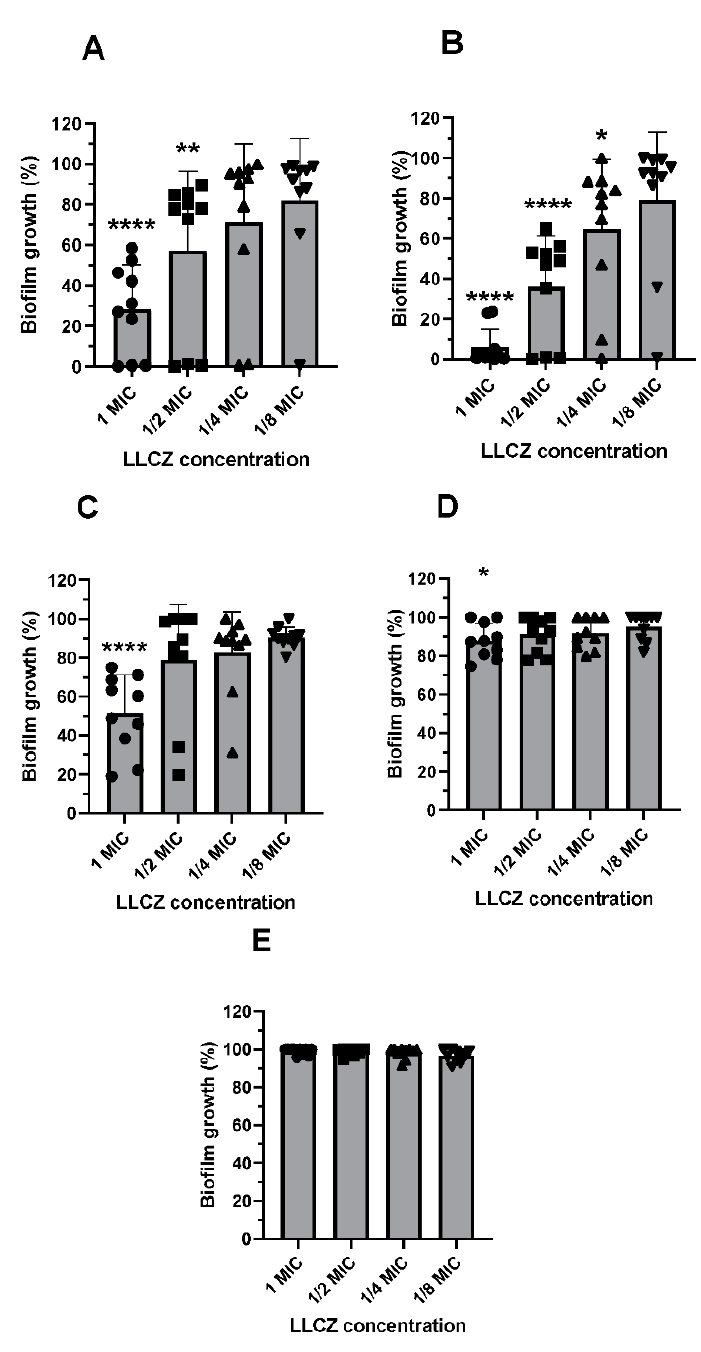
Figure 3. Growth of A. fumigatus biofilm (10 isolates), when treated with luliconazole (XTT assay). Isolates were treated with concentrations of 1- ( • ), 1/2- ( (cid:4) ), 1/4- ( (cid:78) ) and 1/8 ( (cid:72) ) times the isolate specific minimal inhibitory concentration at: ( A ). 0 h ( B ). 4 h, ( C ). 12 h ( D ). 24 h and ( E ). 48 h after incubation start at 35 ◦ C. The isolates were incubated with LLCZ for 24 h at 35 ◦ C and subsequently washed twice with 1 × PBS and incubated with XTT (0.5 mg/mL) + Menadione (25 µ M) for 3 h. The optical density was measured at 492 nm. Statistical significance was determined by Dunnett’s multiple comparison tests, p < 0.05 was stated as significant and the confidence score was indicated by asterisks: *: p < 0.05, **: p < 0.01, ****: p <